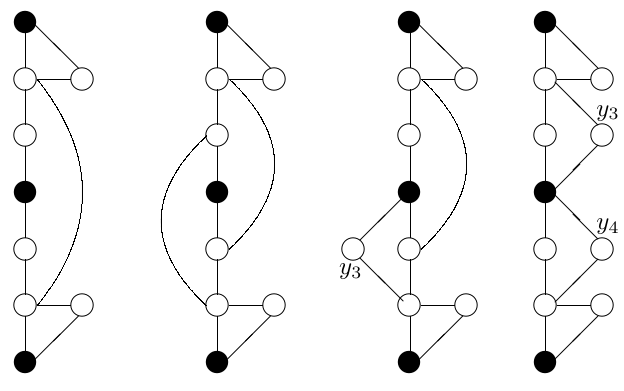
Fig. 21: Fixing v 4 for a maximum backbone tree of type 1 in case [1 . 1]